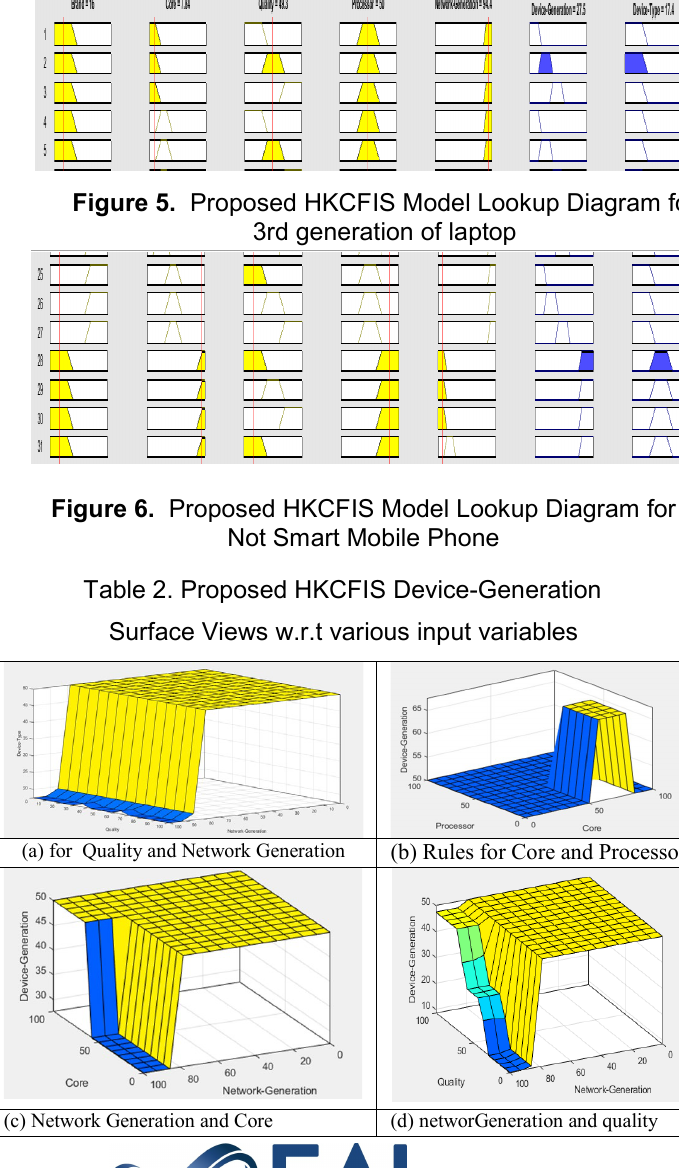
Figure 5. Proposed HKCFIS Model Lookup Diagram for 3rd generation of laptop